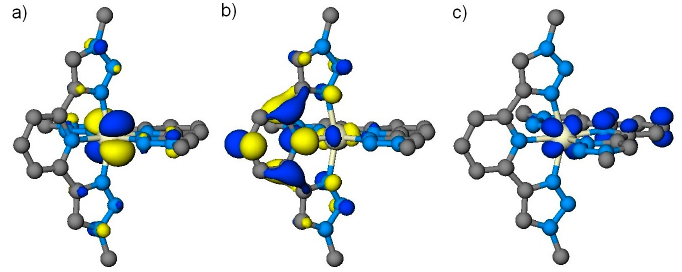
Figure 3. Plots of the HOMO ( a ) and LUMO ( b ) for the ground state of 1 and the spin density for the T 1 state of 1 ( c ).